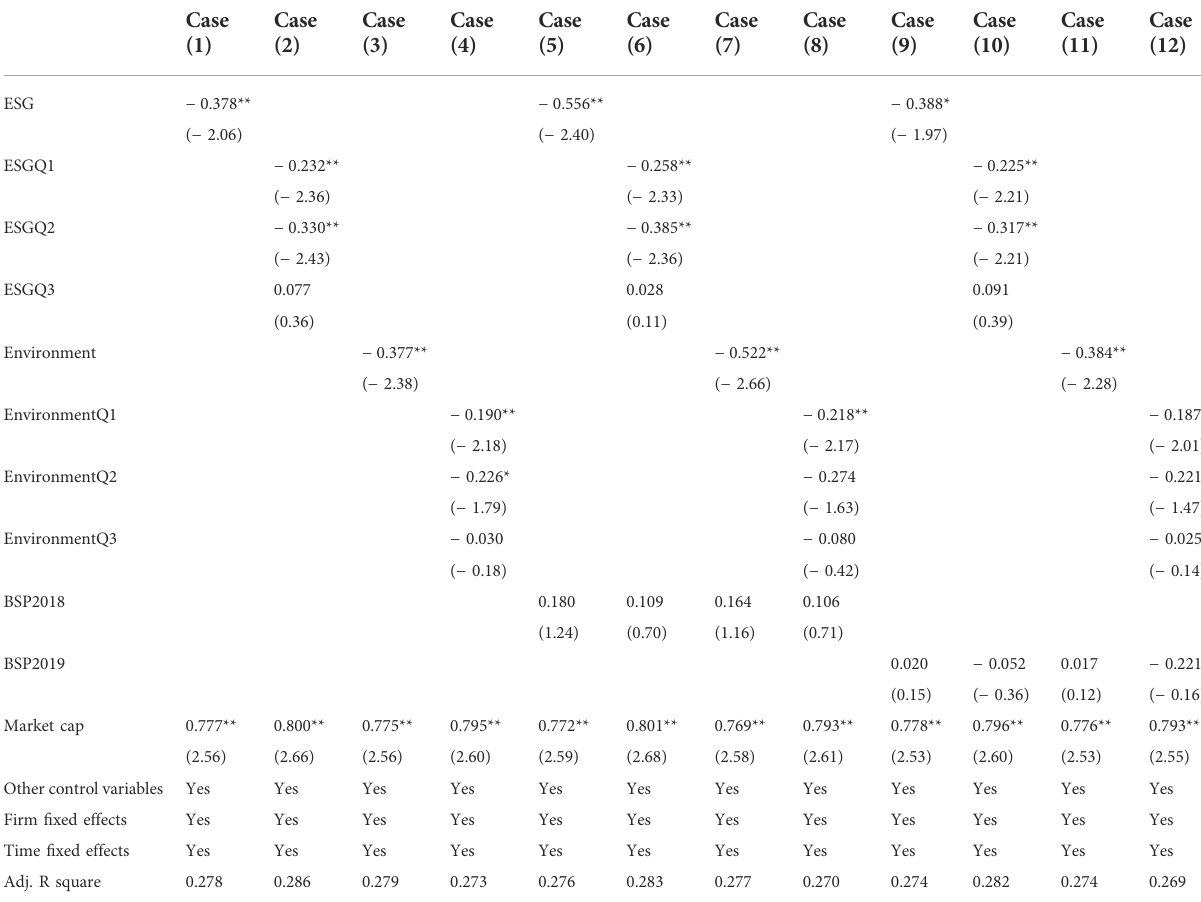
TABLE 3 Policy effects of the “ Blue Sky Plan ” on the fi nancial performance of China ’ s steel industry. Dependent variable: Annual holding period stock